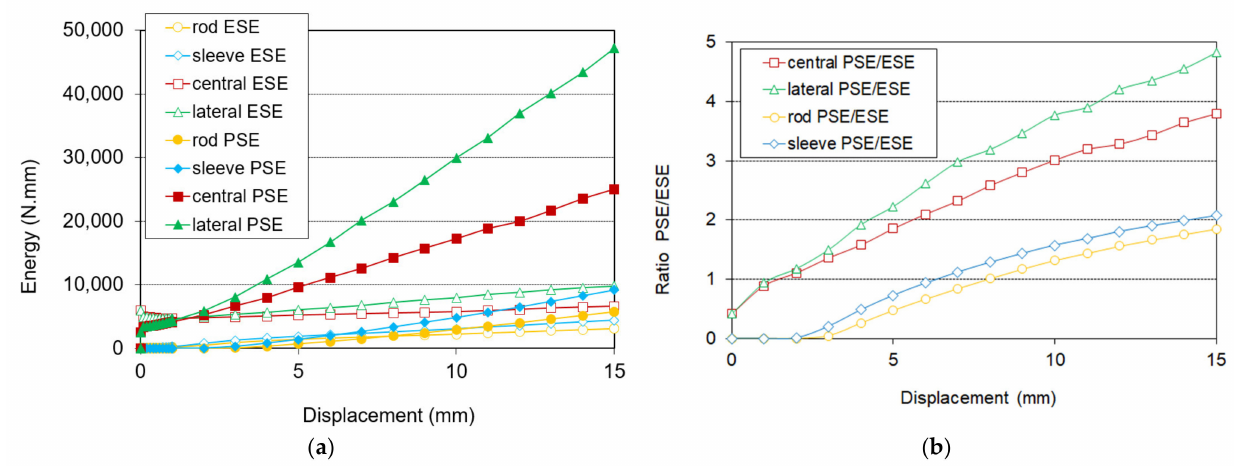
Figure 13. Elastic and plastic mechanical energies in the different parts of the joint when using the expansive kit. ( a ) Energies (N · mm) and ( b ) ratios between plastic and elastic